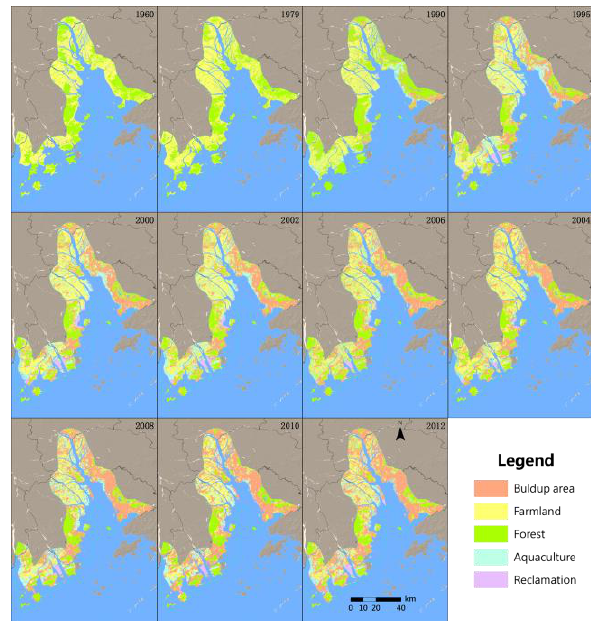
Figure 6. Landuse change in the PRD (1960~2012) 4.3 Relationships between landuse and coastline Based on the results of land expansion and landuse,